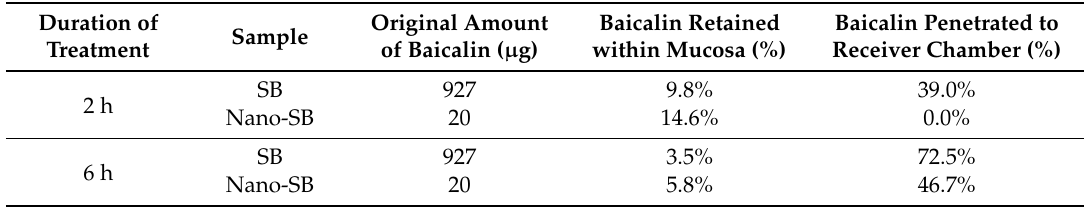
Table 1. Penetration percentage of SB aqueous extract and Nano-SB during the diffusion cell experiment after treatments of 2 h or 6 h.